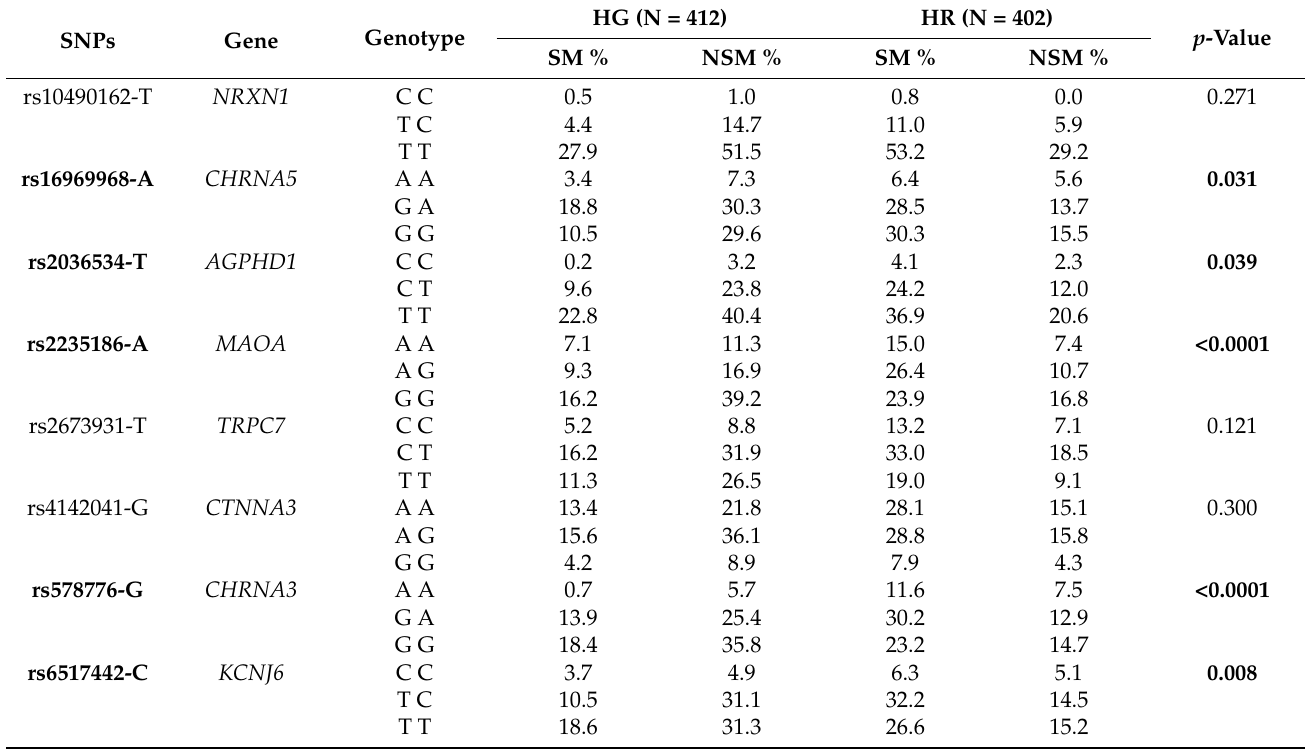
Table 2. Genotype by smoking status in study populations (N =